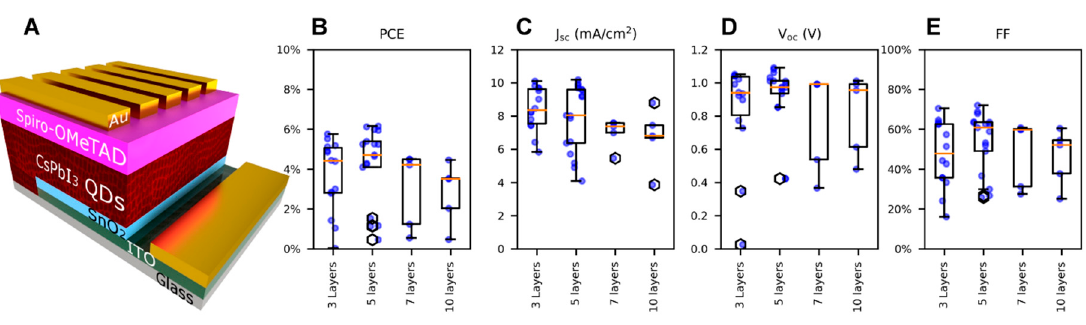
Figure 2. ( A ) Sketch of the perovskite solar cells architecture; photovoltaic statistic (box plot) of the QDs solar cells figures of merit, with different number of layers stacked by spin-coating and ethyl-acetate (EtOAc) washings: ( B ) power conversion efficiency PCE. ( C ) Short circuit current density, J sc . ( D ) Open circuit voltage, V oc . ( E ) Fill factor, FF.